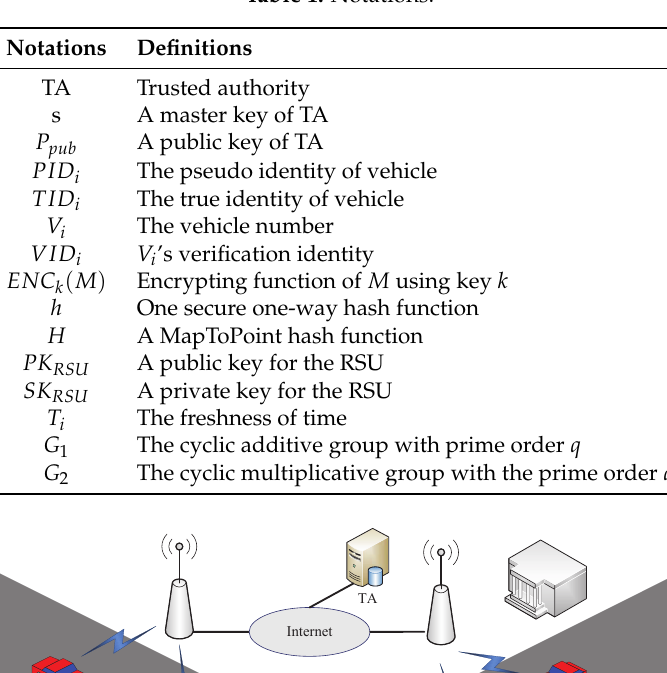
Table 1. Notations.